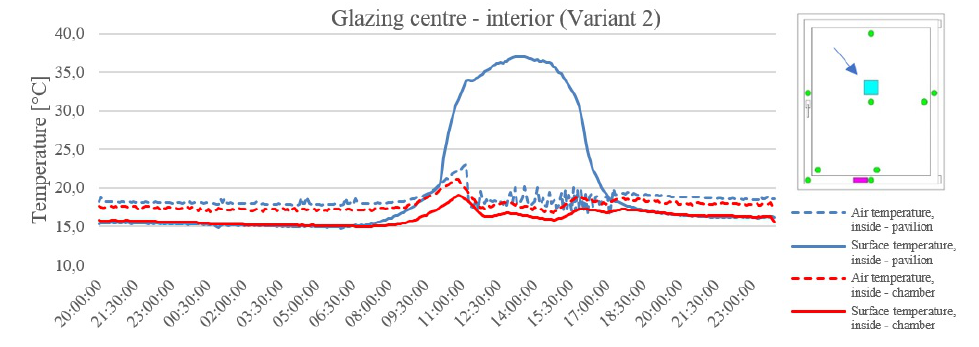
and glazing U w